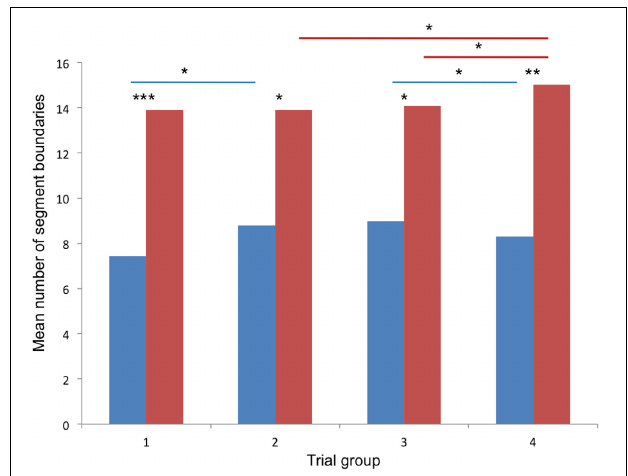
FIGURE 1 | Results of Experiment 1. Mean numbers of segment boundaries defined for the four groups of trials [1: trials 1–5 (early); 2: trials 6–10 (middle); 3: trials 10–15 (late); 4: trials 16–20 (music)]; blue columns: dancers, red columns: non-dancers; asterisks mark significant differences: